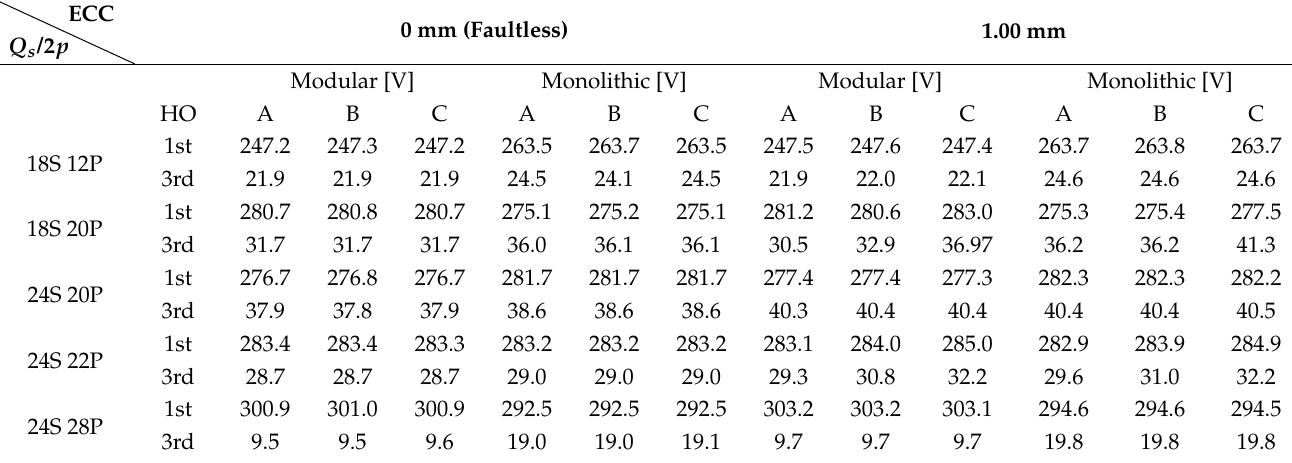
Table 16. Fundamental component and third-order harmonic of back-emf for different PMSM and MPMSM slot/pole combinations in the presence of SE.